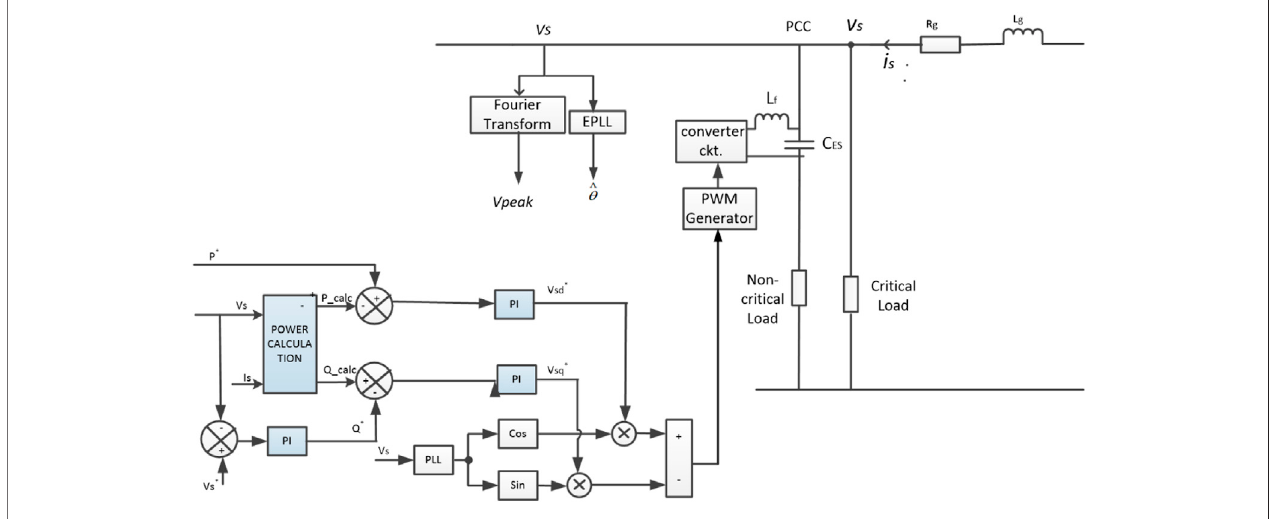
FIGURE 2 | Block diagram representation of PQ control to ES.